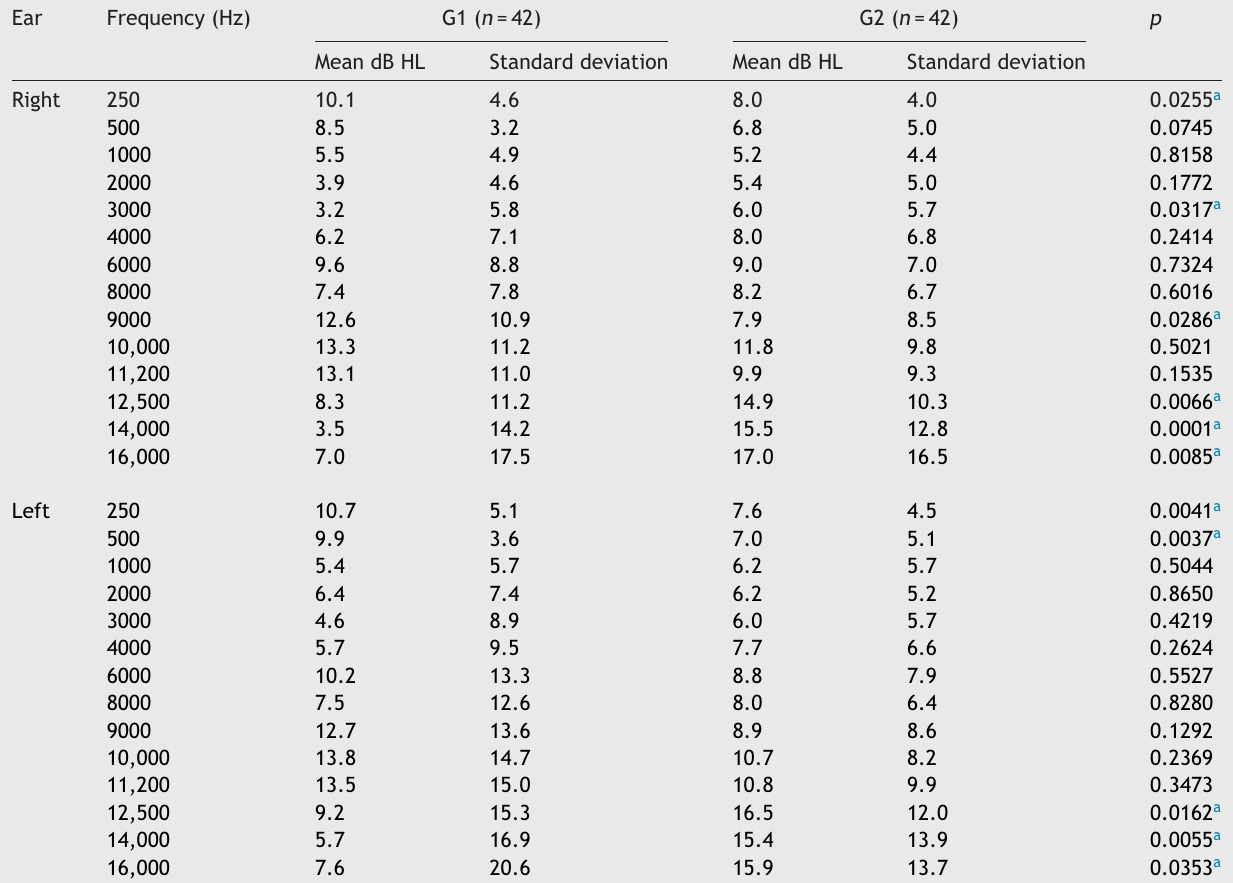
a Student’s t -test with significance level of 0.05.